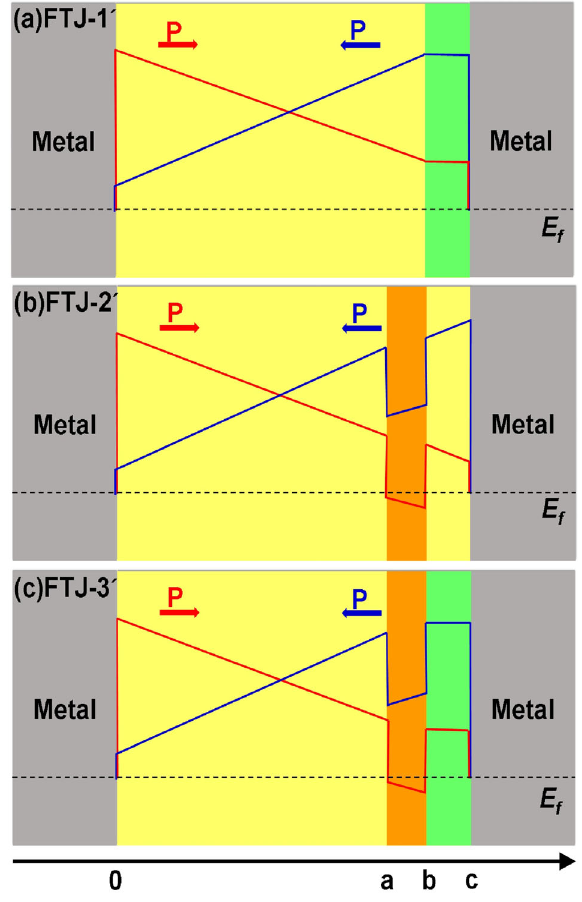
Fig. 6 Schematic diagrams of FTJs corresponding to the FTJs calculated by fi rst-principles calculations. a FTJ-1 ′ , b FTJ-2 ′ , and c FTJ-3 ′ . Gray layer: metal; Yellow layer: ferroelectric; Green layer: dielectric layer; Orange layer: dielectric layer with smaller bands gap. The four interfaces between the layers are at 0, a, b, and c with the left interface is set to be zero.